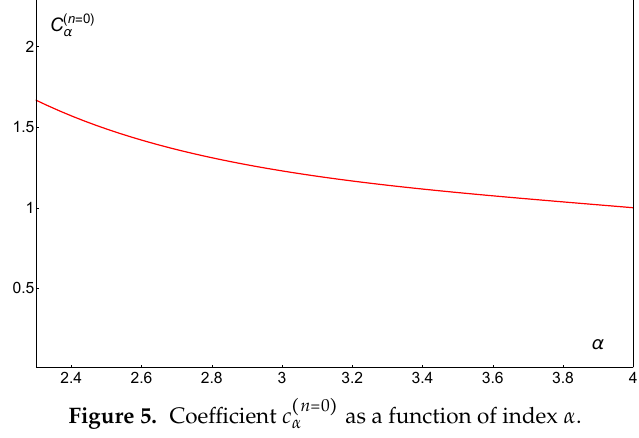
Figure 5. Coefficient c